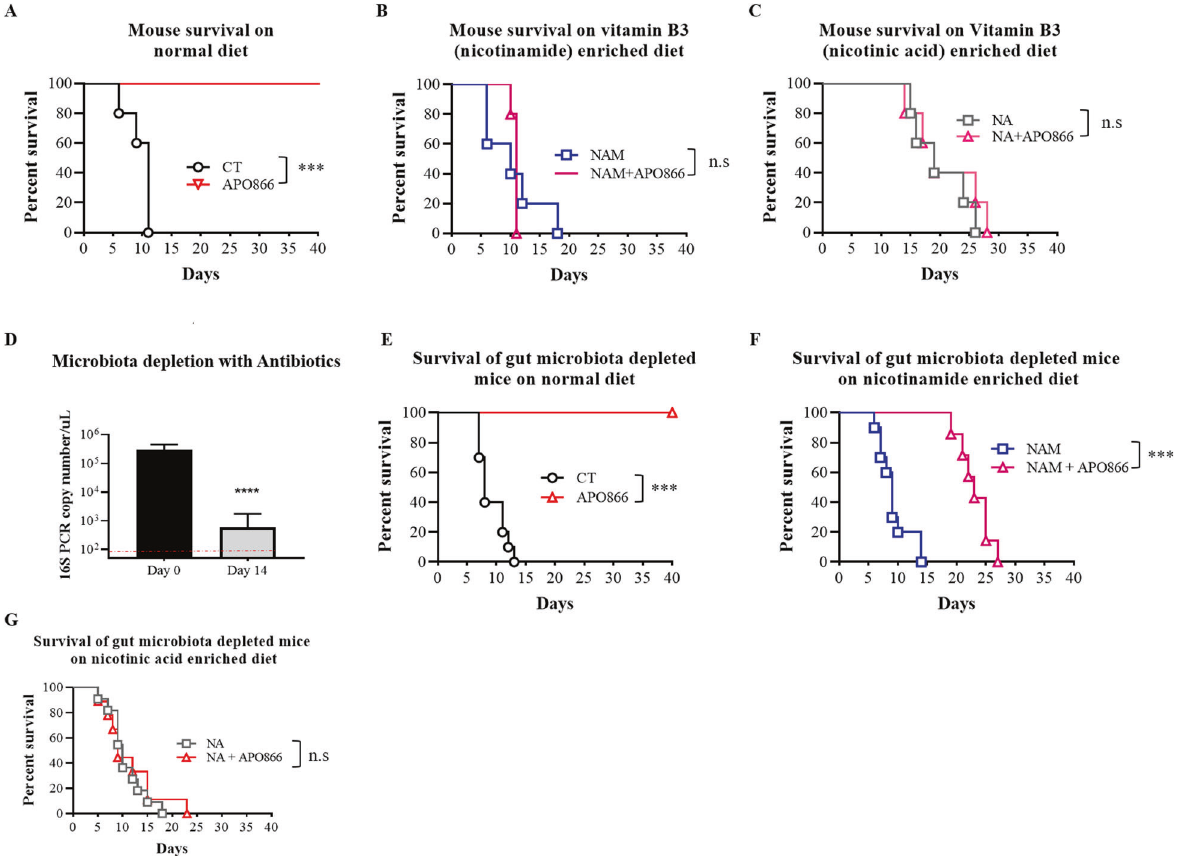
Fig. 6 Tumor metabolic environment and intestinal bacteria severely hamper the in vivo ef fi cacy of APO866 in xenograft model of human leukemia. In vivo ef fi cacy of APO866 on SCID mice with intact ( A – C ; n = 5) or depleted intestinal bacteria ( E – G ; n ≥ 7), xenografted with ML-2 cells and fed with normal diet ( A , E ), enriched diet with NAM ( B , F ), or NA ( C , G ). 6- to 8-week-old C.B.-17 SCID mice were fed with different diets either poor in vitamin B3 (normal diet) or enriched in vitamin B3 (NAM or NA) for two weeks and subsequently treated with or without a cocktail of antibiotics to deplete intestinal microbiota before being transplanted subcutaneously with ML-2 cells. Once tumor sizes of 100 – 150 mm 3 were reached, mice were randomized into a control group (black line) and a treated group (colored line). APO866 administration and tumor volume assessment were conducted as described in “ Methods ” section. All animals were monitored daily, and the study was ended when tumor volume reached around 1000 mm 3 . *** P < 0.001. D 16S rRNA PCR analysis on murine stool samples before and after antibiotic cocktail treatment using universal bacterial primers. Data are mean ± SD, n ≥ 9. Dot line indicates lower limit detection for